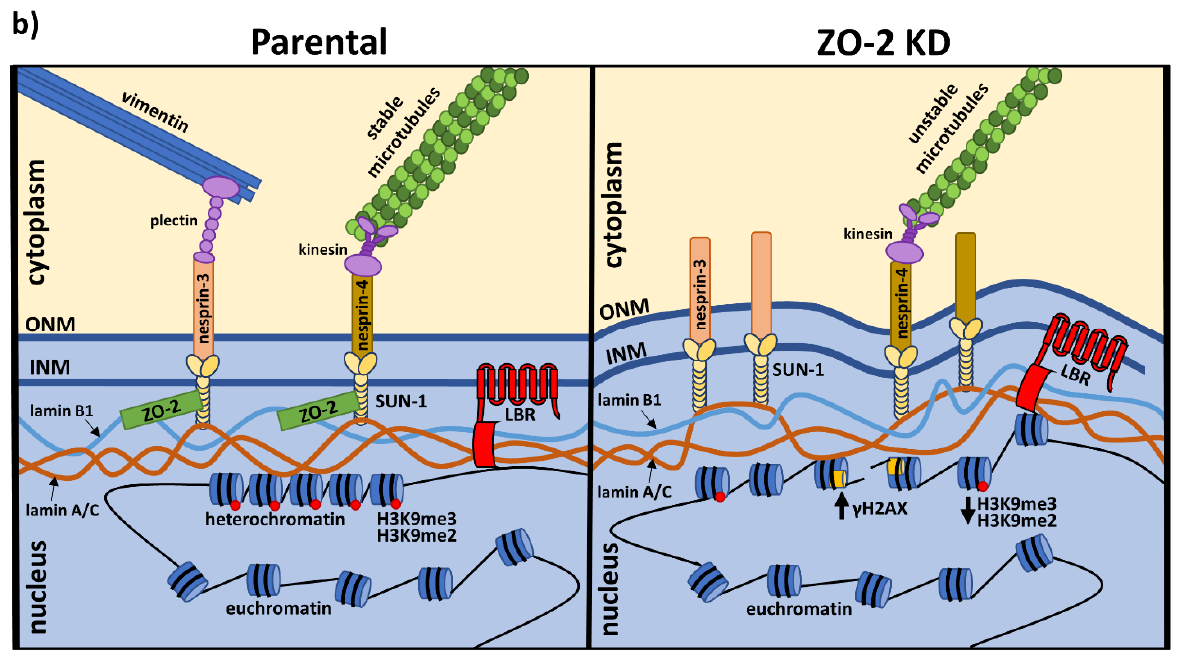
Figure 8. Schematic representation of main observations . ( a ) Cell-cell contacts, extracellular calcium, and ZO-2 are required by epithelial cells to maintain the normal nuclear shape. ( b ) ZO-2 association to proteins at the inner nuclear membrane, which forms part of the LINC complex that links the nucleoskeleton to the cytoskeleton. ZO-2 at the nucleus associates with lamin B1 and SUN-1. The latter is an inner nuclear membrane protein that associates with nesprins-3 and -4, which, through plectin and kinesin, respectively, bind to vimentin and microtubules. In the absence of ZO-2, the nuclei become lobulated with multiple indentations; constitutive and facultative markers of HC H3K9me3 and H3K9me2 respectively diminish, and DNA DSBs, identified with γ -H2AX, are more abundant than in parental cells. These changes are accompanied by an over-expression of SUN-1 and nesprins-3 and -4; a diminished expression of vimentin; and instability of microtubules. These observations suggest that the contact of ZO-2 with proteins in the inner nuclear membrane is crucial for the maintenance of the nuclear shape. ONM, outer nuclear membrane; INM, inner nuclear membrane; LBR, lamin B receptor.